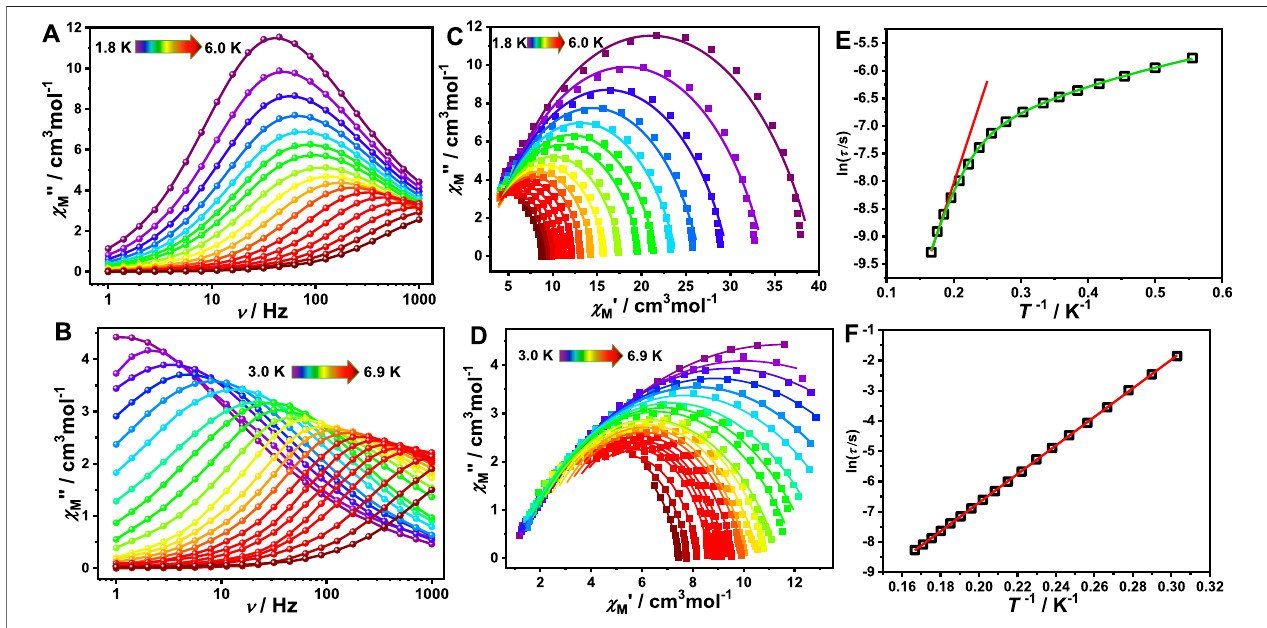
FIGURE5| Frequency-dependentoftheout-of-phase( χ ″ )underzeroDC- fi eld (A) andunder1,000 Oe (B) ofcomplex 1 ;Cole − ColecurvesunderzeroDC- fi eld (C) and under 1,000 Oe (D) of complex 1 . Solid lines represent the best fi t with Debye model. Plot of ln ( τ /s) versus T − 1 under zero DC- fi eld (E) and under 1,000 Oe (F) for complex 1 , where the red solid line represents the fi tted results using the Arrhenius formula and the green solid line represents the fi tted results using Eq. 1 .